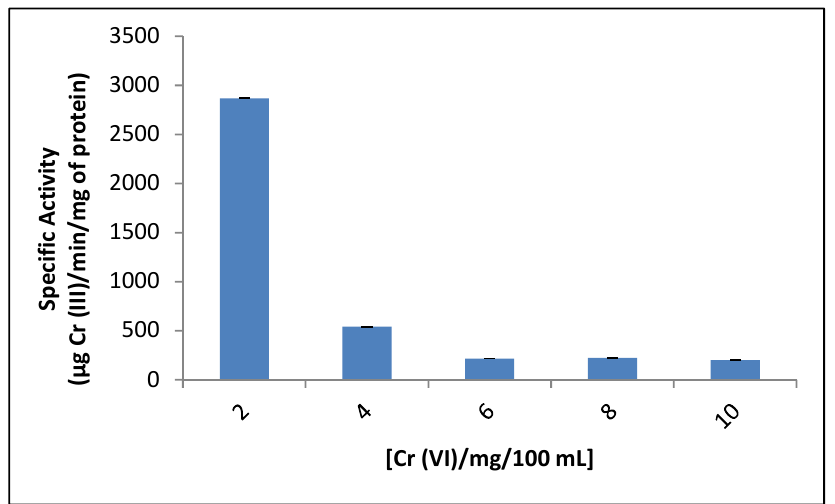
Figure 4. Effect of different initial concentrations of Cr (VI) on crude reductant activity in the mixed membrane fraction of Purpureocillium lilacinum . 1 h of incubation, pH 7.0, 100 rpm, and 37 °C.